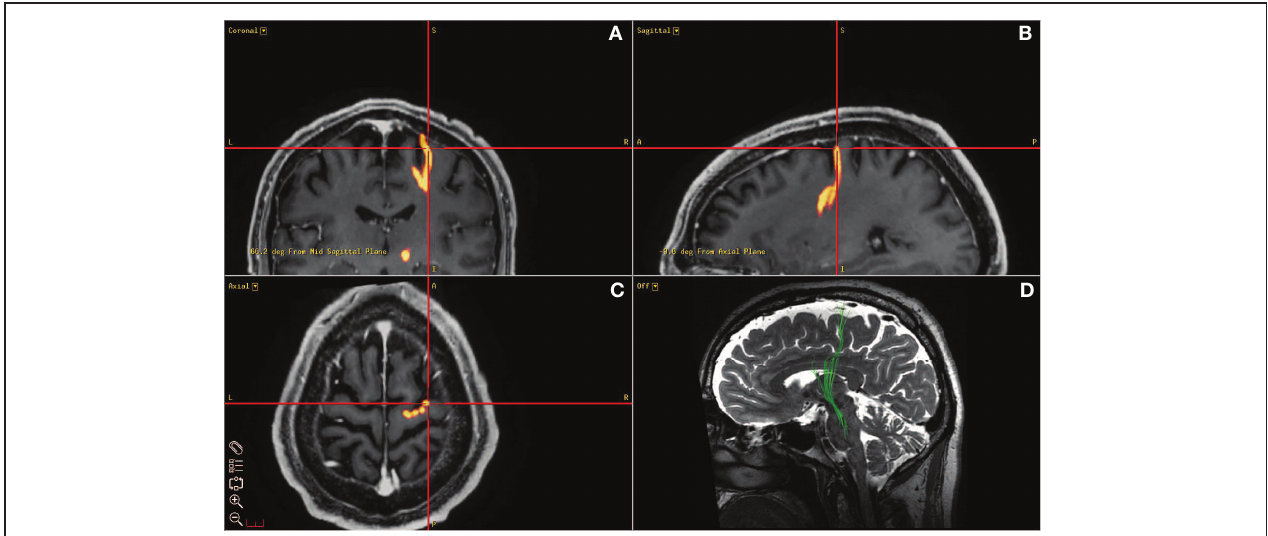
FIGURE 2 | Diffusion tensor imaging used to guide ECoG strip placement. (A) , (B) , (C) depict a screen capture from the StealthViz neuronavigational system showing the localization of the origin of the “hyperdirect pathway” as targeted during surgery. (D) Sagittal view of a DTI image used to guide the positioning of the ECoG strip during surgery. Deterministic fiber tracking was first performed using a commercial software package (StealthViz, Medtronic Navigation, Louisville, CO). A trapezoidal region of interest was defined initially at 12mM lateral to the midline, 4mM below the anterior commissure–posterior commissure (AC–PC) plane,